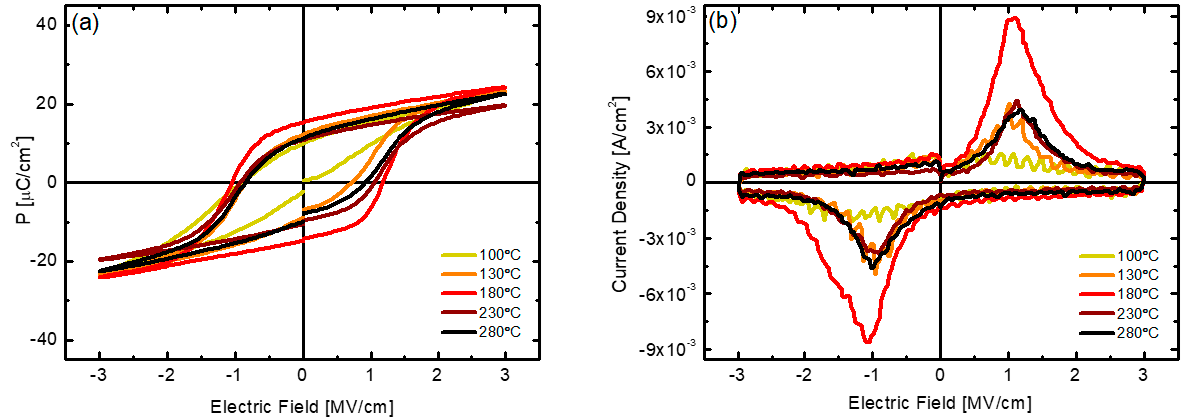
Figure 6. ( a ) P − E hysteresis curve and ( b ) polarization switching current curve with respect to electric field of HZO thin films deposited at various substrate temperatures.